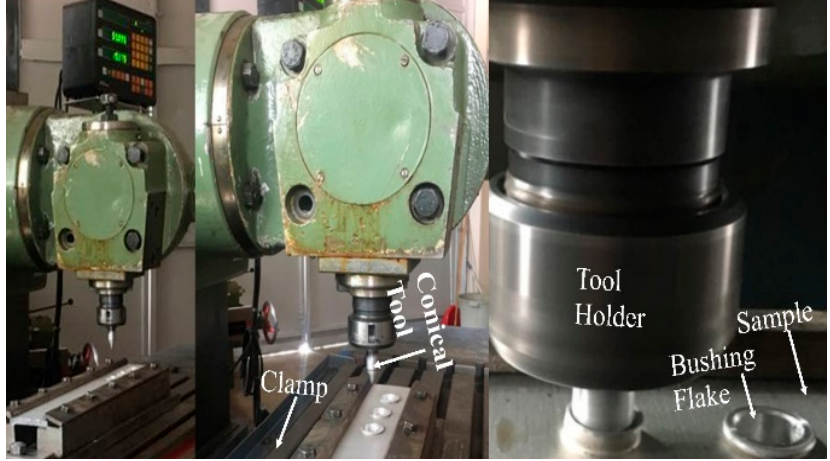
Figure 1. Experimental setup with conical tool and fastening apparatus.